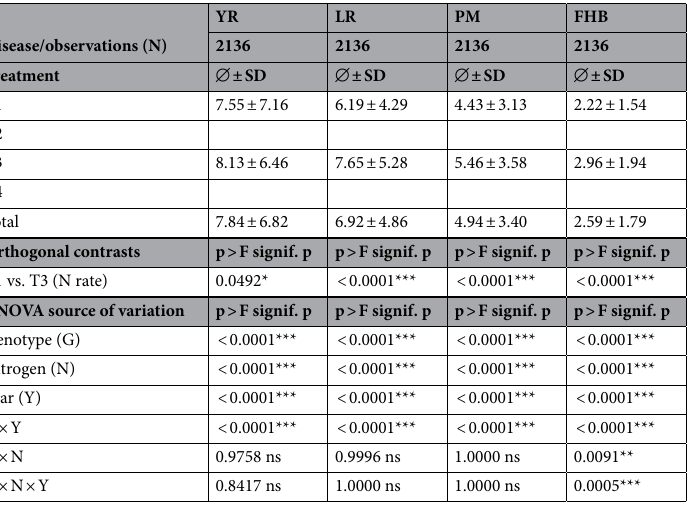
Table 1. Summary statistics of disease scores (average ordinate, AO) for four fungal pathogens, orthogonal contrasts between treatments based on LSmeans and ANOVA results for 3-year field trials 2014/15, 2015/16, 2016/17 obtained on 178 wheat cultivars. YR, stripe rust, % diseased leave area (Average Ordinate, AO); LR, leaf rust, % diseased leave area (AO); PM, powdery mildew, % diseased leave area (AO); FHB, Fusarium head blight, % diseased ear area (AO); T1–T4, treatments T1 (target supply 110 kg N ha −1 + inoculation), T2 (target supply 110 kg N ha −1 + fungicides), T3 (target supply 220 kg N ha −1 + inoculation), T4 (target supply 220 kg N ha −1 + fungicides); ∅ , mean; SD, standard deviation; Signif. p, significance level of p value: *** < 0.001, ** < 0.01, * < 0.05, ns not